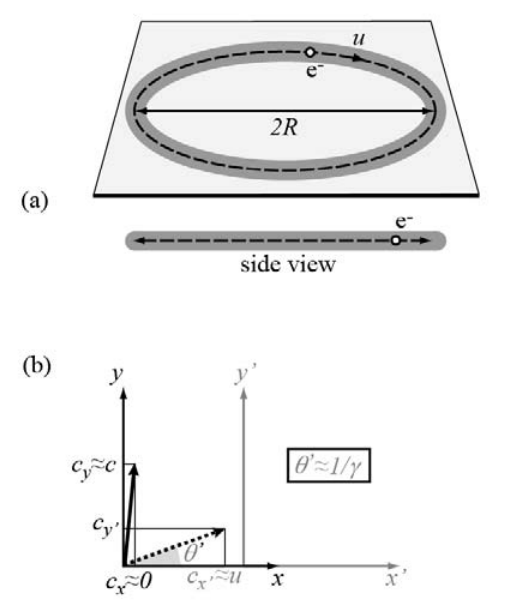
Figure 3. Schematic explanation of the “torchlight” emission of synchrotron light. Top: an electron circulating in a storage ring, when seen from the side, looks like a charge oscillating in a linear antenna. For nonrelativistic electrons, the emission occurs over a broad angular range and is centered in the x-ray domain. Bottom: the Lorentz velocity transformation squeezes the broad angular emission range in the electron frame to a very narrow cone in the laboratory